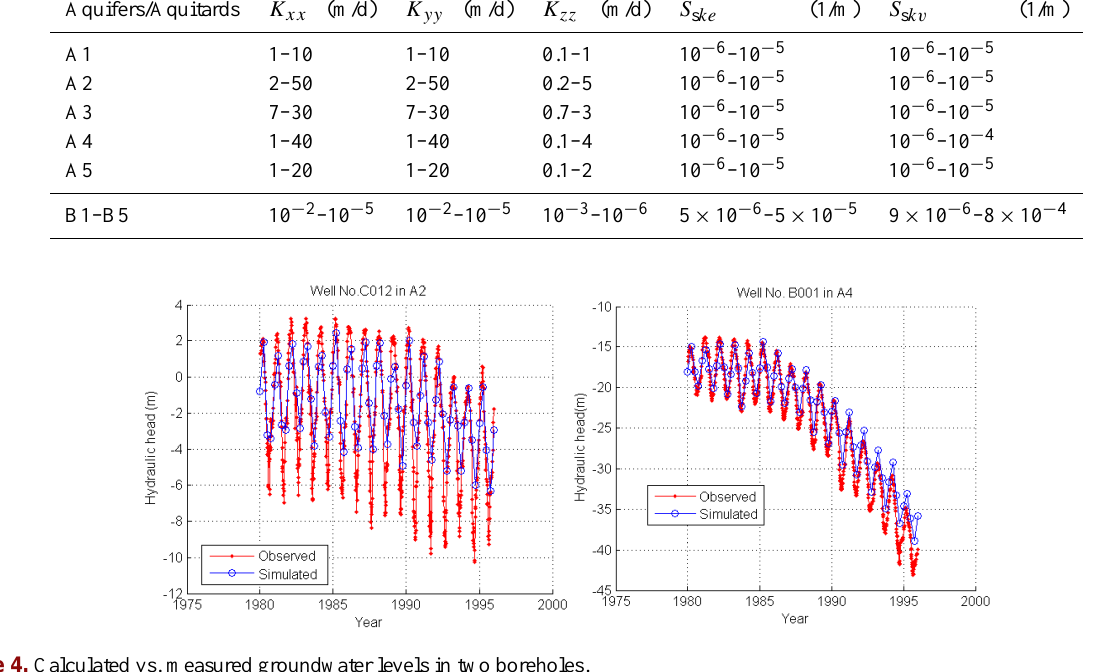
Figure 4. Calculated vs. measured groundwater levels in two boreholes.